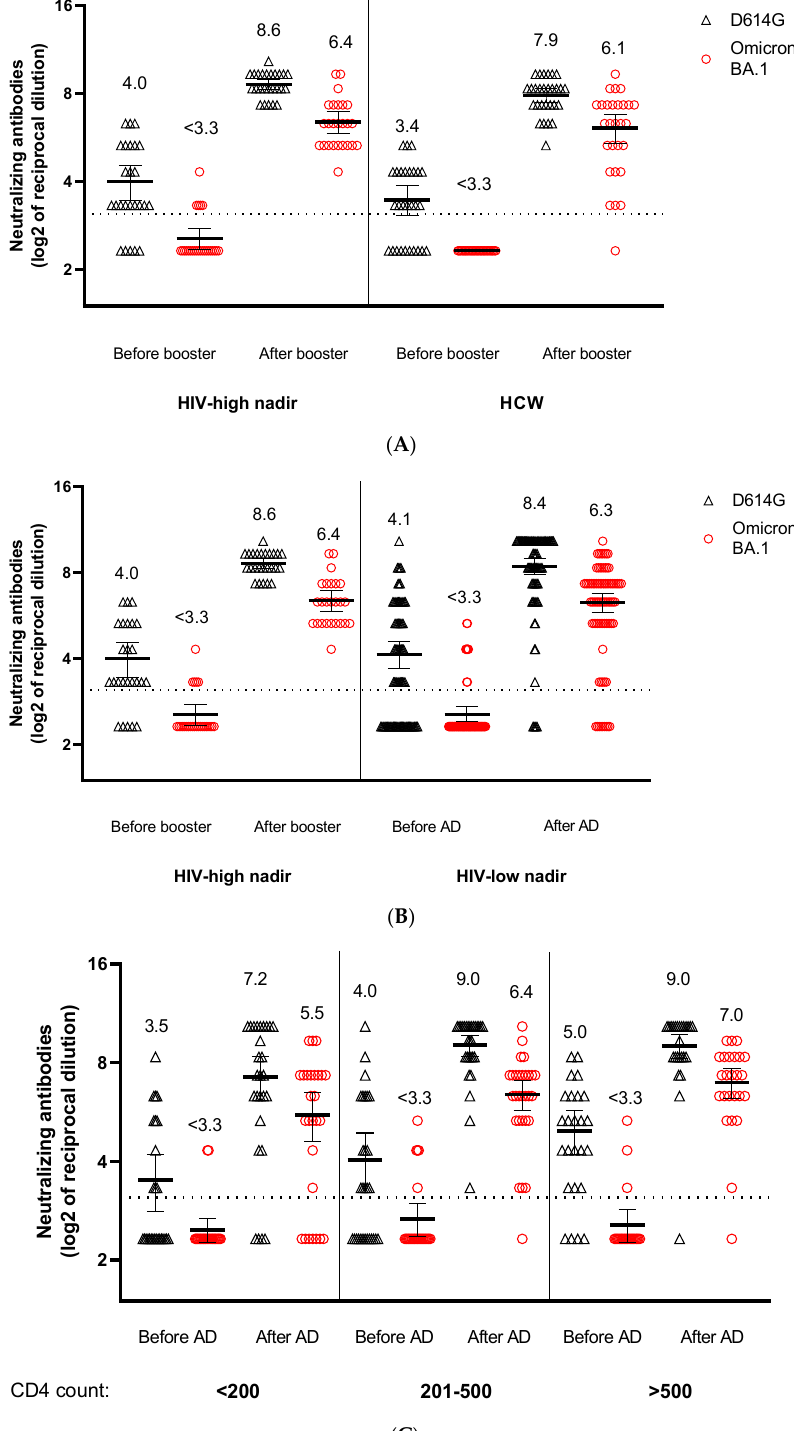
Figure 1. Log 2 mean titers of neutralizing antibodies against Wuhan-D614G and BA.1 in ( A ) PLWH with high CD4 count/high nadir and health care workers (HIV-negative); ( B ) PLWH with low and high CD4 nadir; ( C ) PLWH with low CD4 nadir and with CD4 count < 200/mm 3 , 201–500/mm 3 , >501/mm 3 at the time of third vaccine